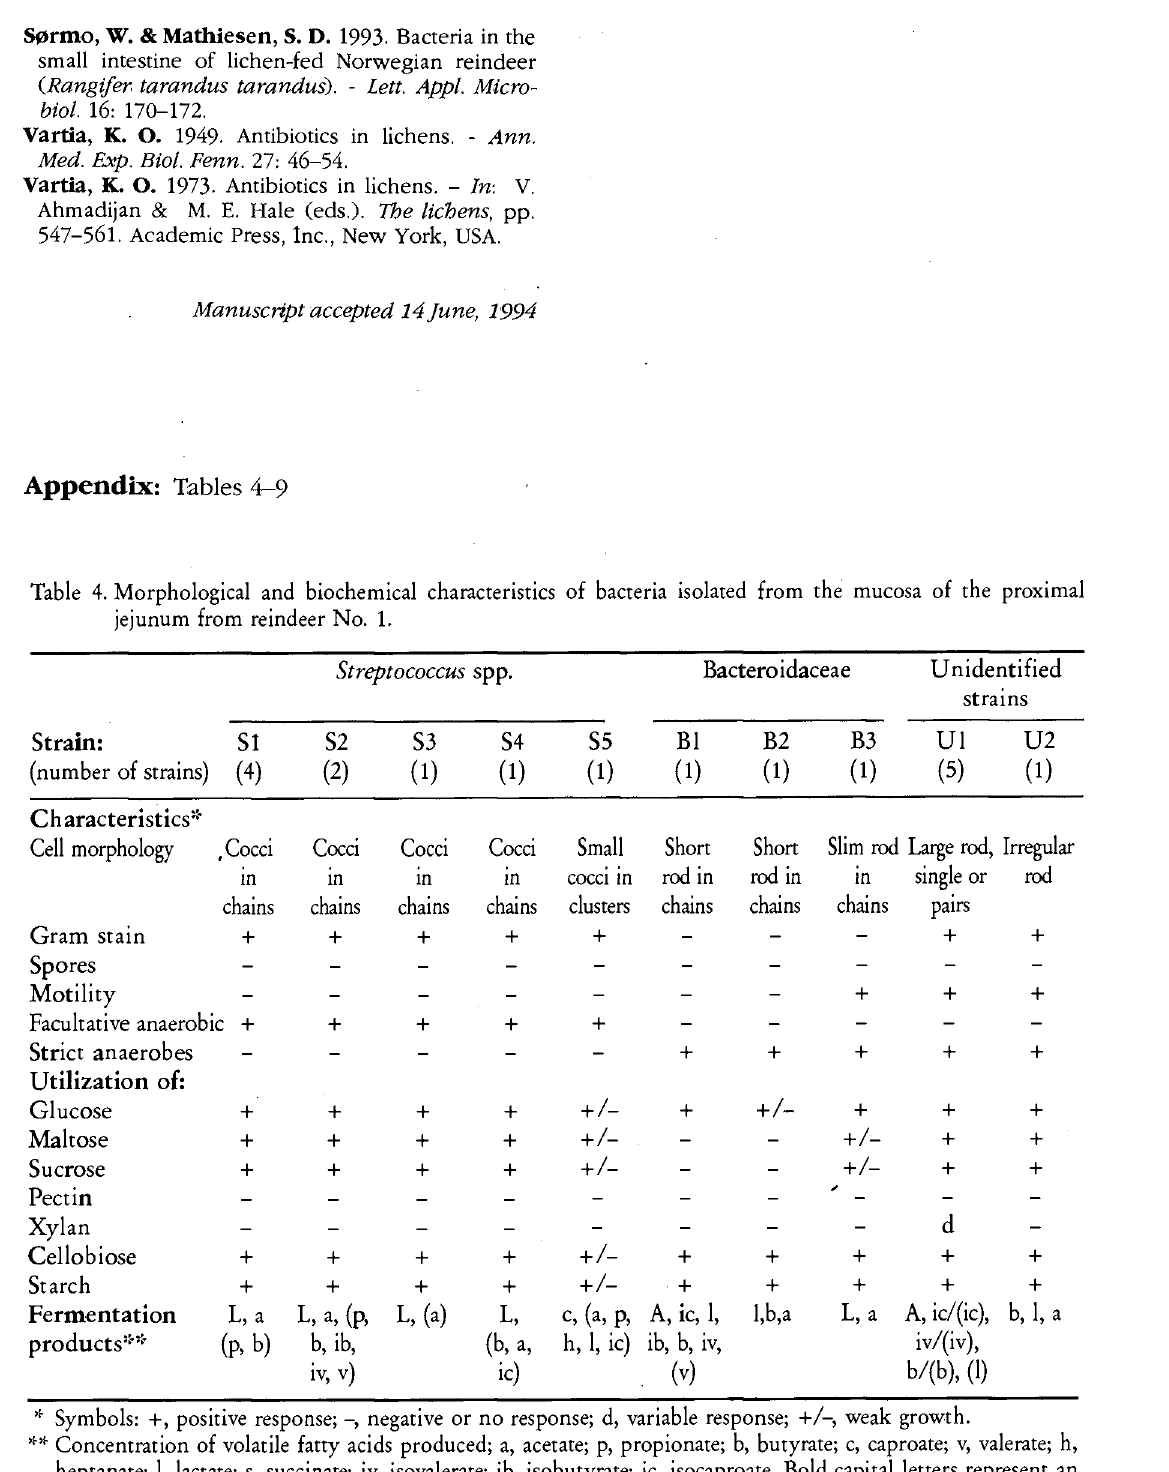
Table 4. Morphological and biochemical characteristics of bacteria isolated from the mucosa of the proximal jejunum from reindeer No. 1. Streptococcus spp. Bacteroidaceae